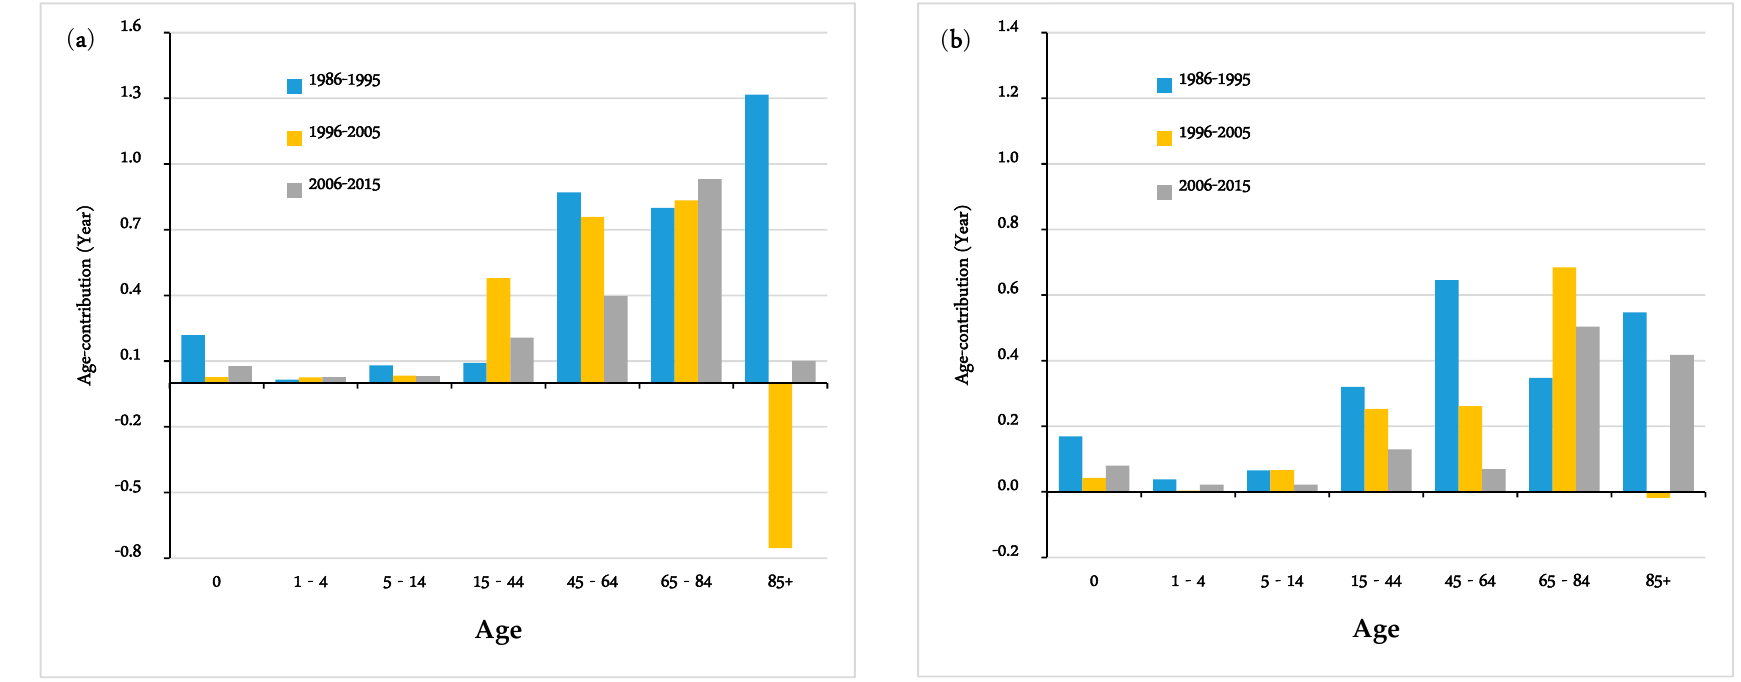
Figure 1. Arriaga’s decomposition of the change in life expectancy by age group between 1986 and 2015 in Hong Kong: ( a ) Males; ( b ) Females.